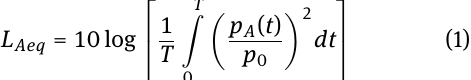
In Figures 1–6, numbers on the horizontal axis show consecutive 24-hour periods in the year, numbered from 1 to 365; night sub-interval (hours from 22 to 6) is counted as part of the 24-hour period ending at 6 a.m. The L Aeq